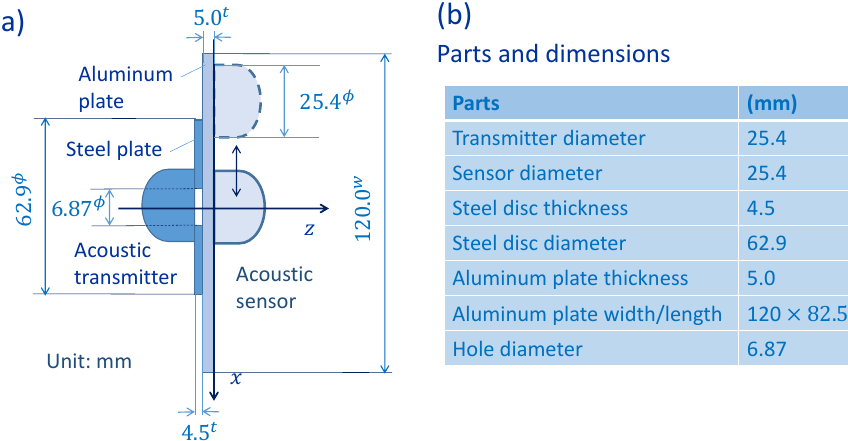
Figure 5. ( a ) Hardware configuration. Parts are not proportionally scaled. ( b ) Parts and dimension.